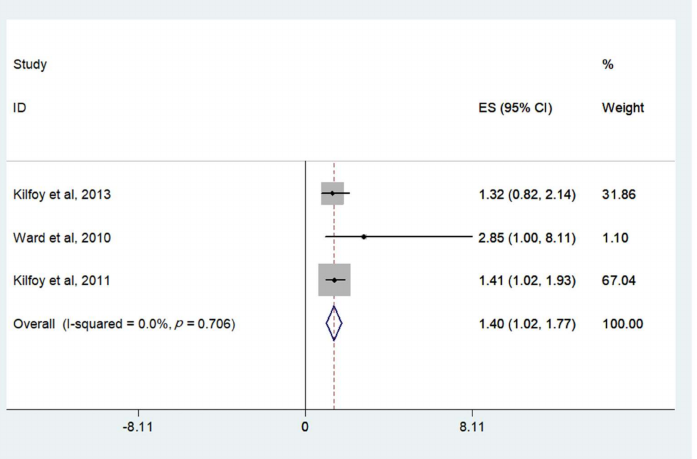
Figure 3. ORs (95% CI) for thyroid cancer of the highest versus lowest category of dosage of dietary nitrate consumption for the following selected studies .